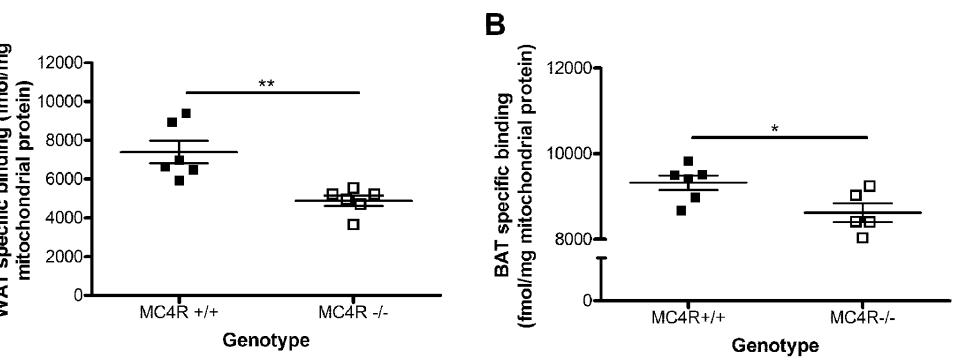
Figure 3. TSPO is down-regulated in white and brown adipose tissue of MC4R 2 / 2 mice. Binding of TSPO ligand 3 H-PK11195 in (A) white adipose tissue (WAT) and (B) brown adipose tissue (BAT) mitochondrial extracts revealed significantly lower expression of TSPO binding sites in MC4R 2 / 2 mice as compared to wild-type littermate controls (MC4R + / + ). Data are expressed as mean 6 standard error. n=5–6. Statistical significance of * p , 0.05 and ** p , 0.01 was determined by unpaired t-test.